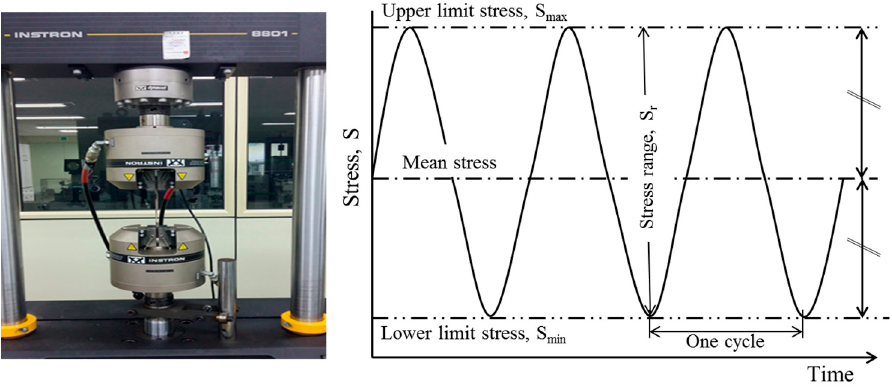
Figure 4. Appearance of the fatigue machine and schematic diagram of stress loading during the fatigue test.